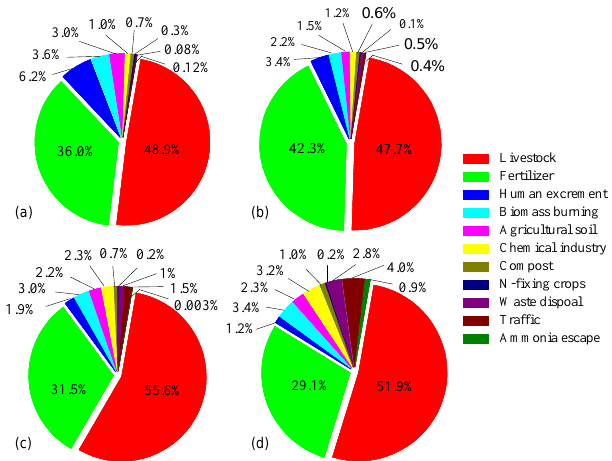
Figure 4. Source contributions (%) to NH 3 emissions in China: (a) 1980; (b) 1996; (c) 2006; (d) 2012.